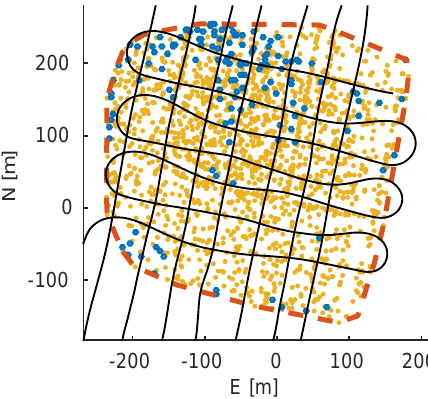
Figure 7: Contour lines of the canyon every five meters in